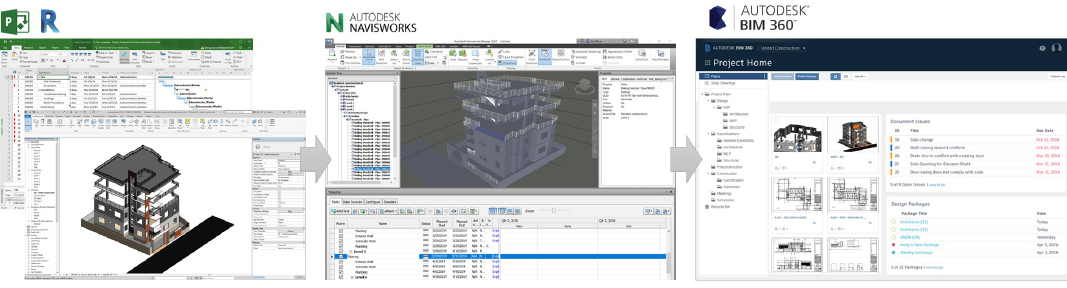
Figure 13. Process of delivering TSF on local